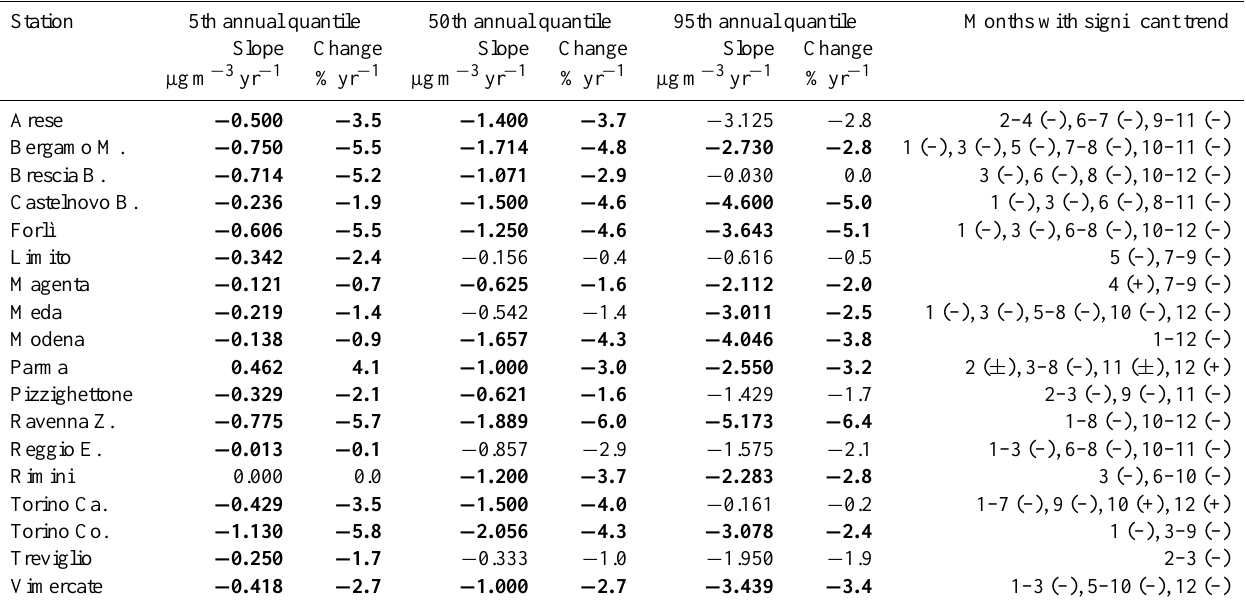
Table 3. Analysis of trend for annual quantiles and for monthly frequency of PM 10 . Slope for annual quantiles is computed by the Theil–Sen method: boldface values indicate slope significantly different from zero at 95% confidence